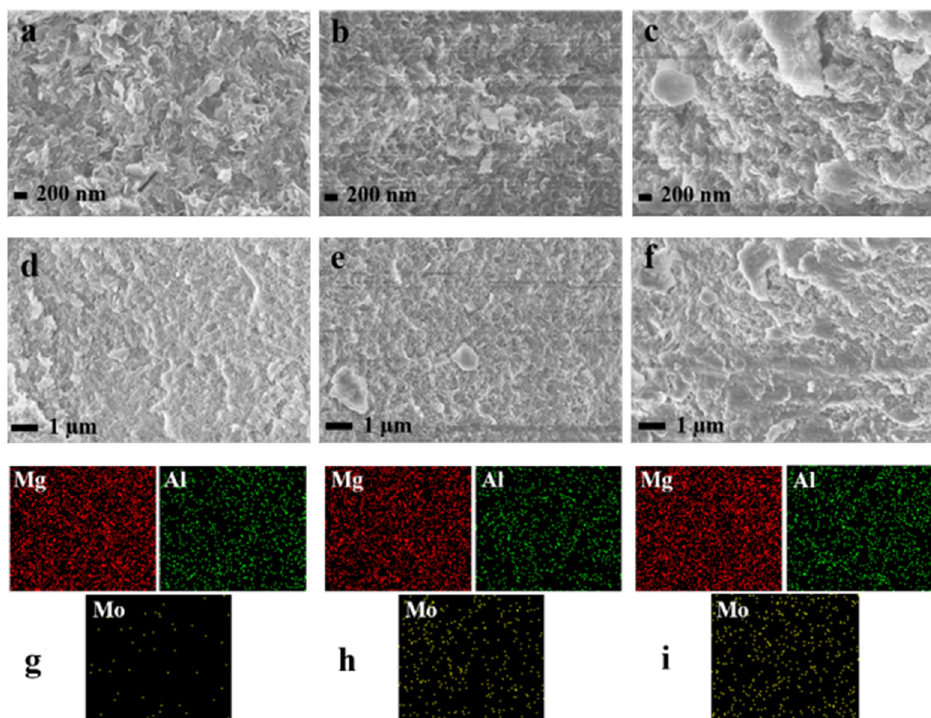
Figure 3. SEM images of fresh catalysts: ( a , d ) 12.5 wt% Mo/LDO; ( b , e ) 22.3 wt% Mo/LDO; ( c , f ) 30.1 wt% Mo/LDO and the elemental mapping: ( g ) 12.5 wt% Mo/LDO; ( h ) 22.3 wt% Mo/LDO; ( i ) 30.1 wt% Mo/LDO.